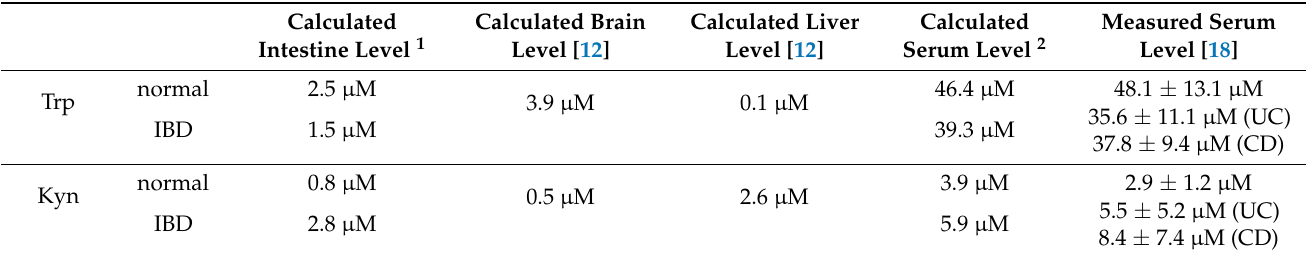
Table 1. Comparison between calculated and experimentally measured concentrations of tryptophan (Trp) and kynurenine (Kyn) in human